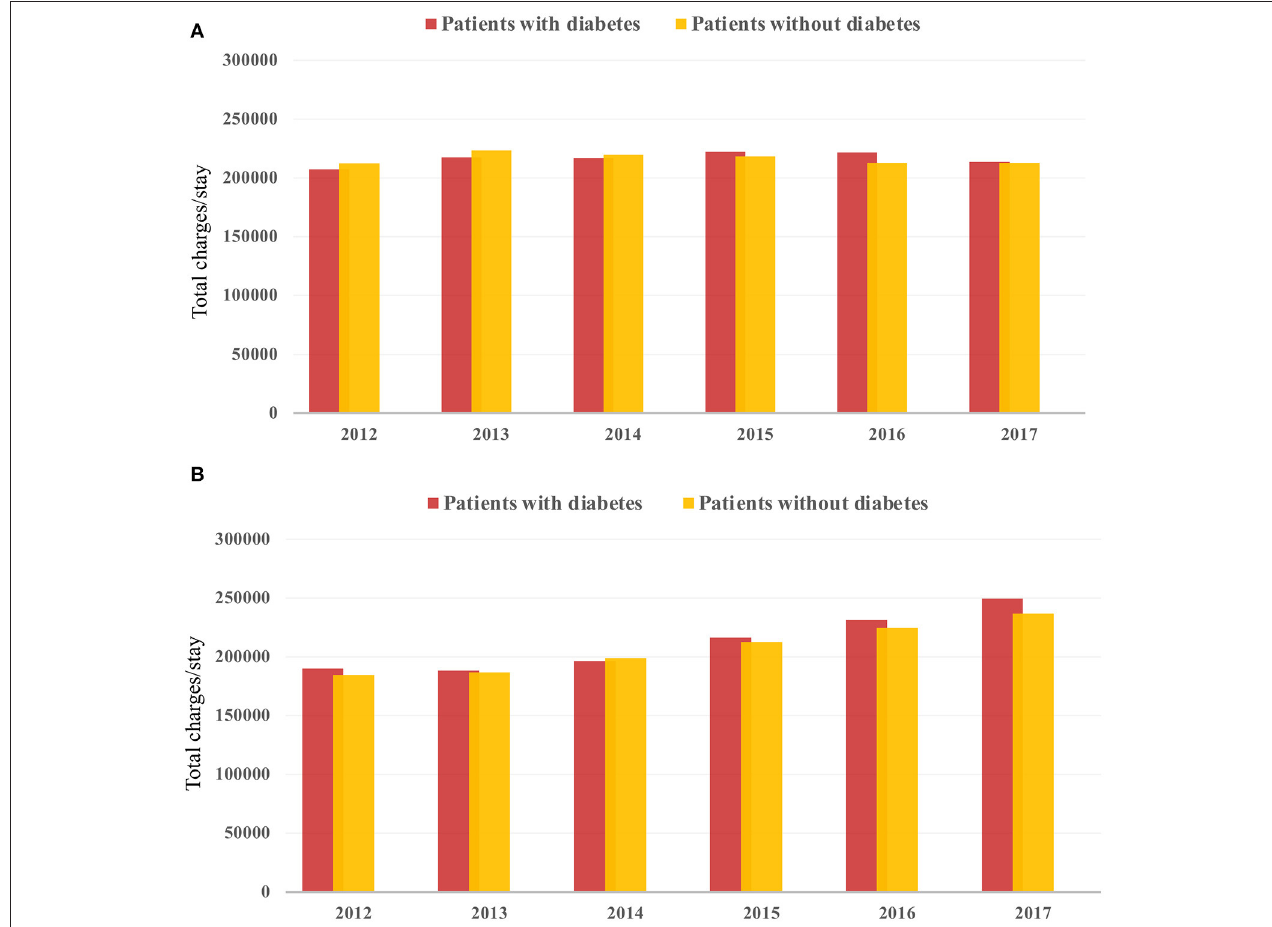
FIGURE 4 | Temporal trend in total hospital charges from 2012 to 2017 in (A) TAVR and (B) sAVR patients.